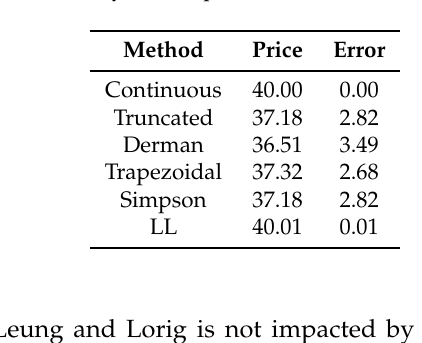
Table 3. Prices in volatility obtained by static replication of a variance swap under high volatility (40%).